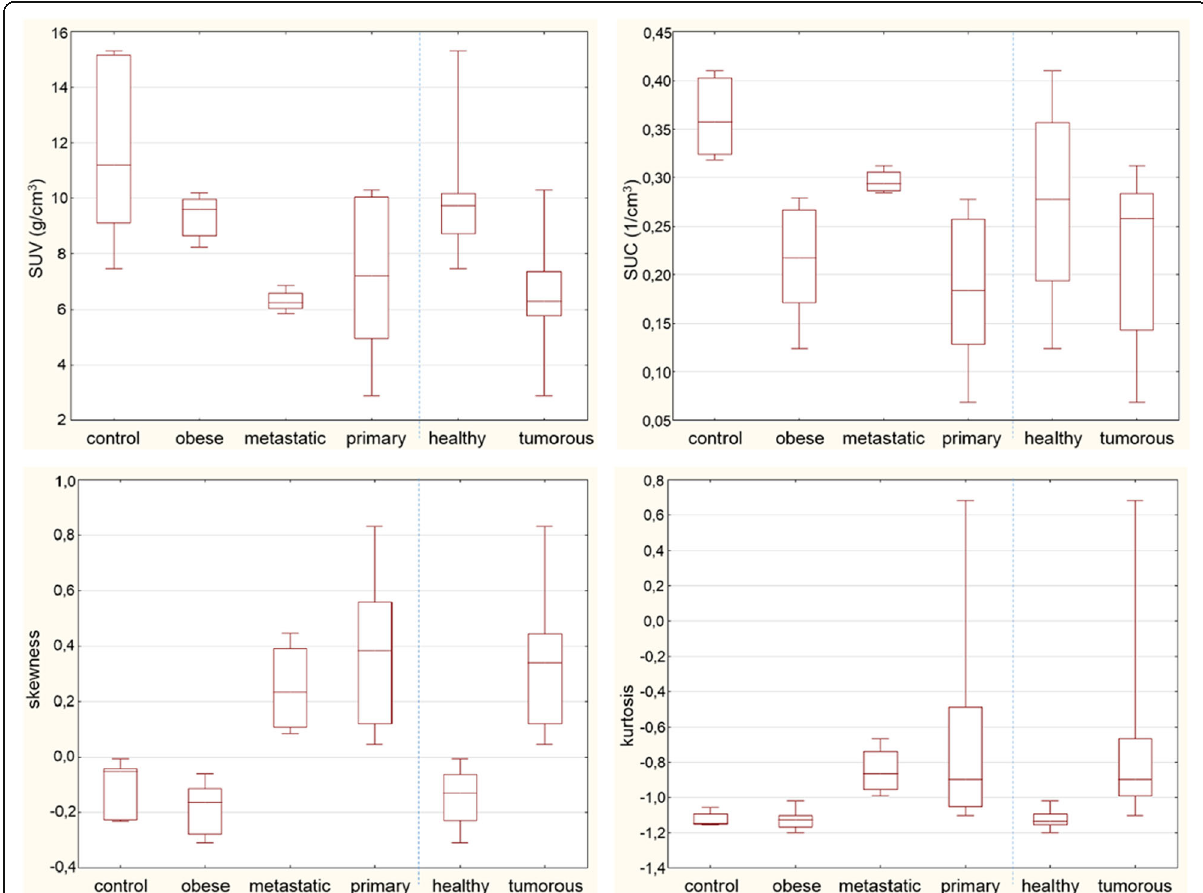
Fig. 3 Box plots show the liver volume of interest parameters (SUV, SUC, skewness, and kurtosis) in different groups (control n = 6, obese n = 8, metastatic n = 4, primary n = 9, healthy n = 14, tumorous n = 13) (middle line: median, box: quartiles, whiskers: